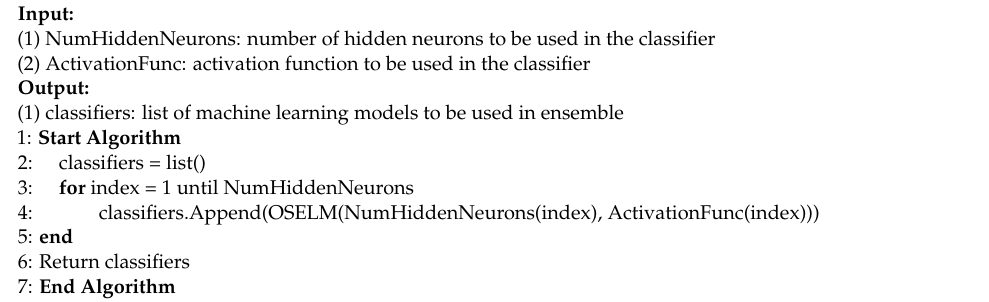
Algorithm 4. Pseudocode of initialisation of the incremental GPC with classifier.